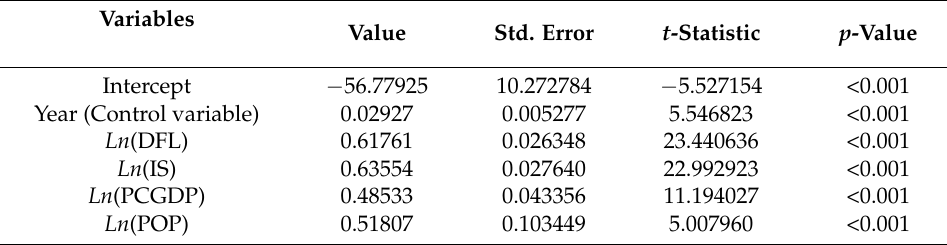
Table 3. Regression results of factors driving the